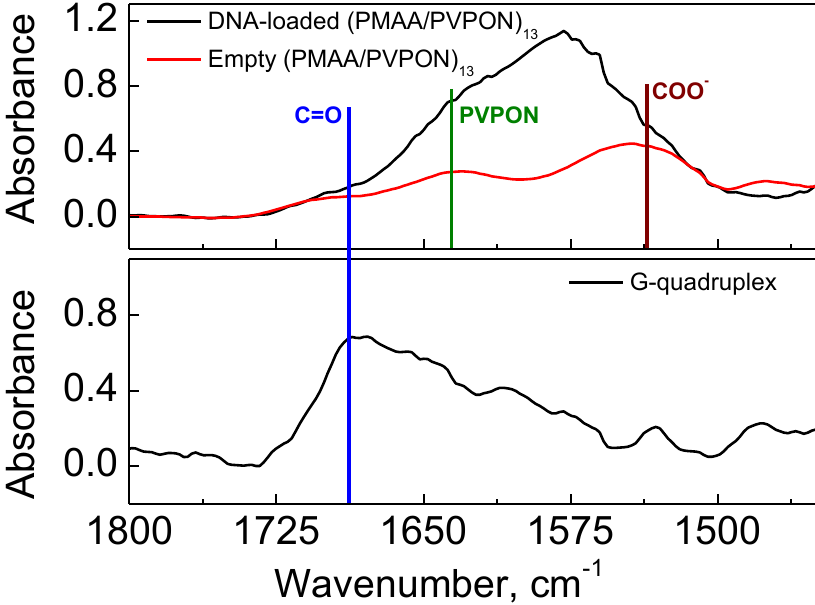
Figure 3. FTIR spectra of (top; red trace) empty and (top; black trace) G-quadruplex DNA-loaded (PMAA/PVPON) 13 multilayer hydrogel capsules; and (bottom; black trace) non-encapsulated G-quadruplex oligonucleotides.